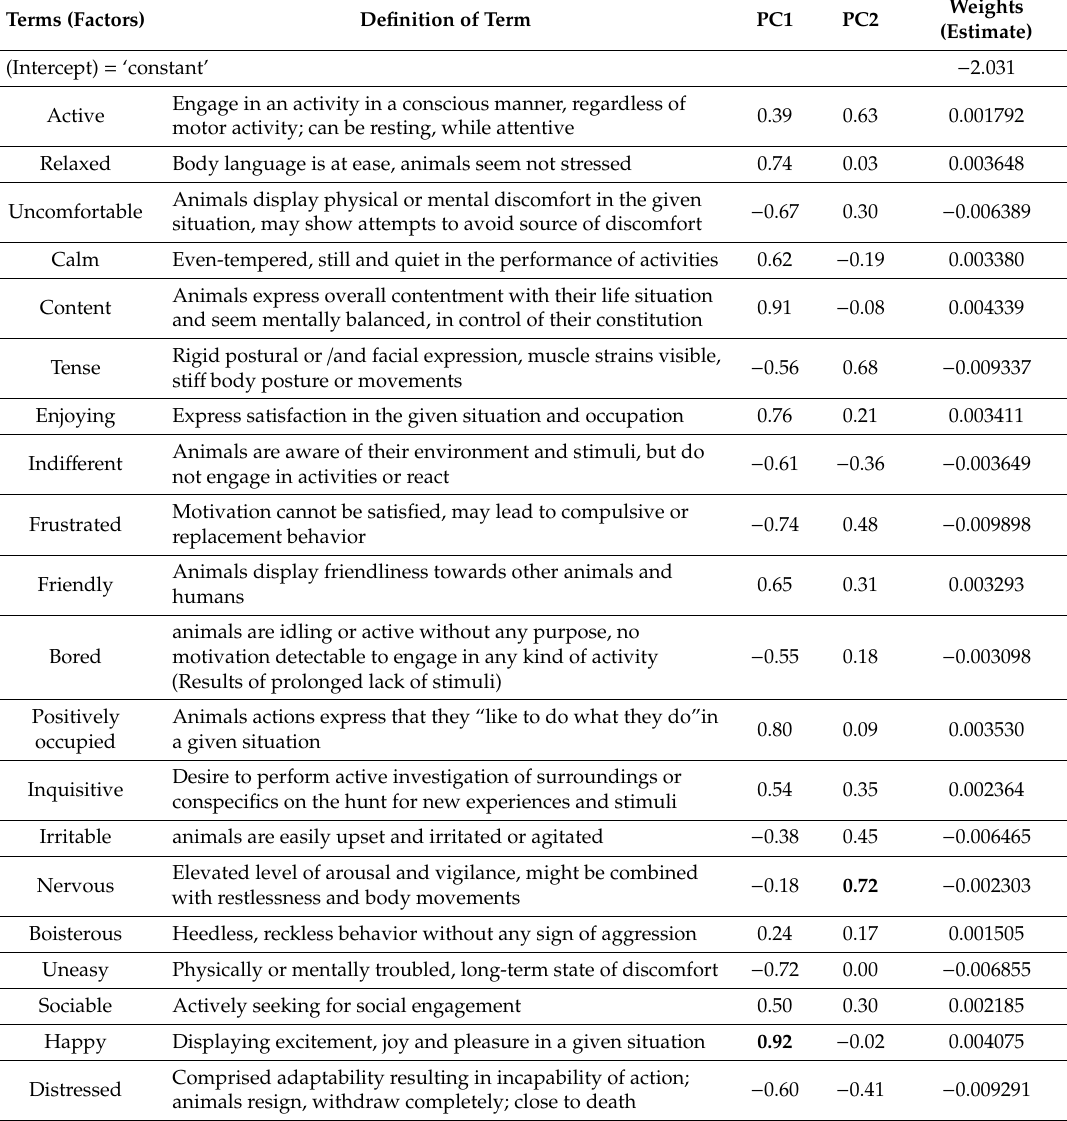
Table 1. QBA fixed-term list (20 terms) with definition of terms, loadings of Principal Component 1 and 2 (PC1 and PC2) and extracted weights for the simplified score